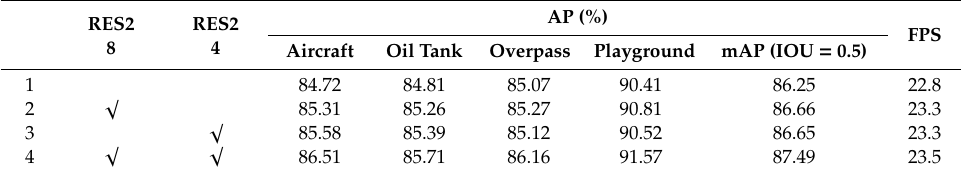
Table 13. The influence of ‘Res2 block’ on remote sensing target detection with four detection layers.